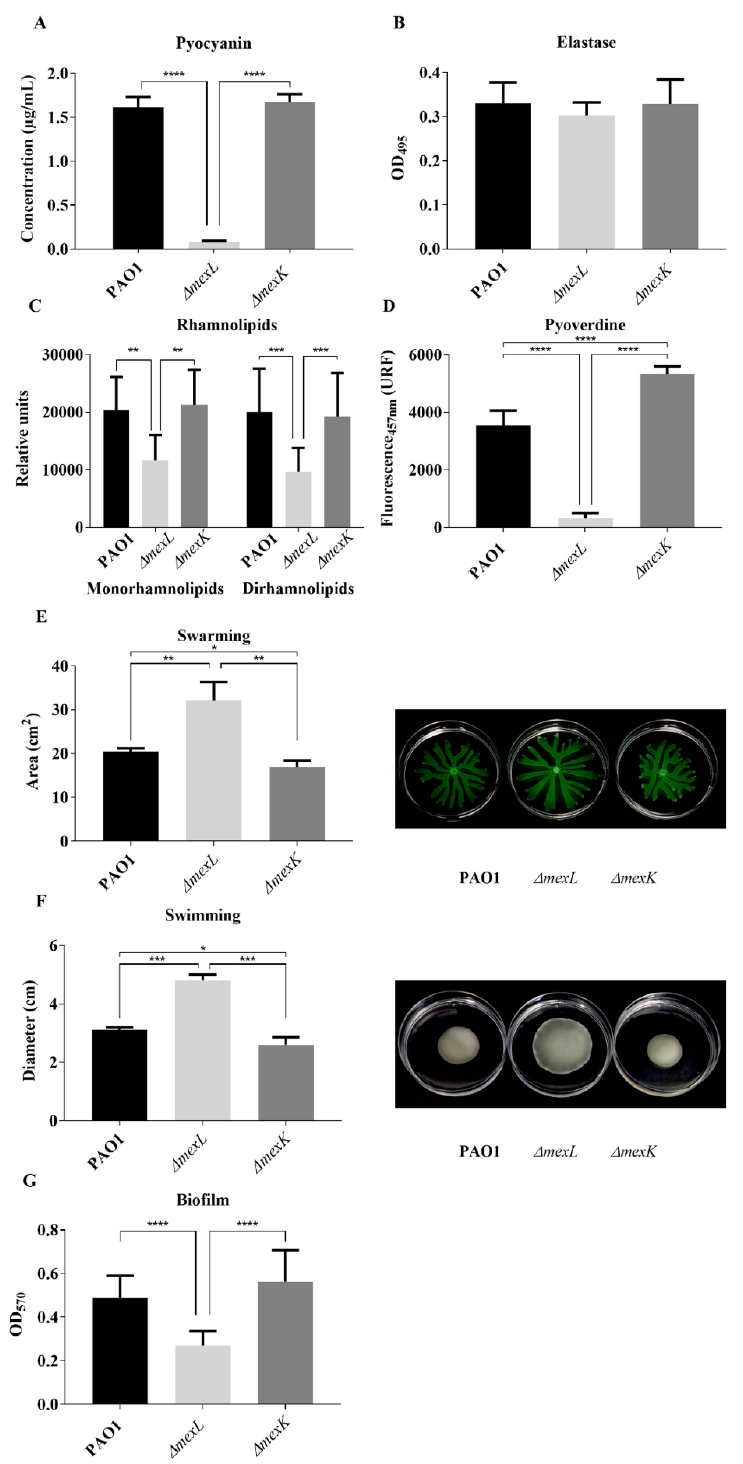
Figure 8. Analysis of the overexpression and deletion of the MexJK efflux pump in the production of different virulence factors regulated by QS. The production of ( A ) pyocyanin, ( B ) elastase, ( C ) rhamnolipids, and ( D ) pyoverdine was analyzed in supernatants of PAO1, ∆ mexL , and ∆ mexK strains grown in LB medium for 20 h. For ( E ) swarming and ( F ) swimming motility assays, a specific medium was used as described in Methods. For the analysis of ( G ) biofilm production, a modification of the Calgary device was used. Values that are significantly different by an unpaired two-tail t -test are indicated by asterisks as follows: * p < 0.05; ** p < 0.01; *** p < 0.001; **** p <